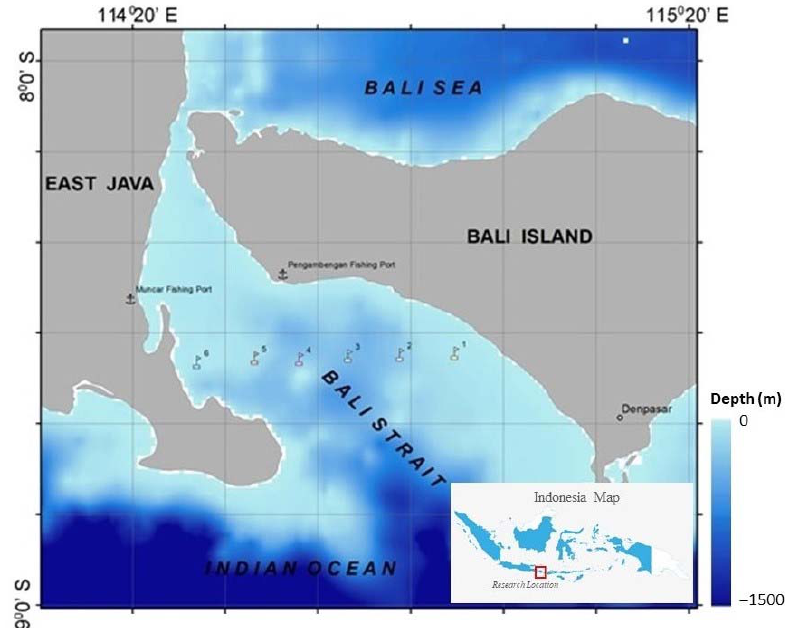
Figure 5. Study area of the Bali Strait, Indonesia.